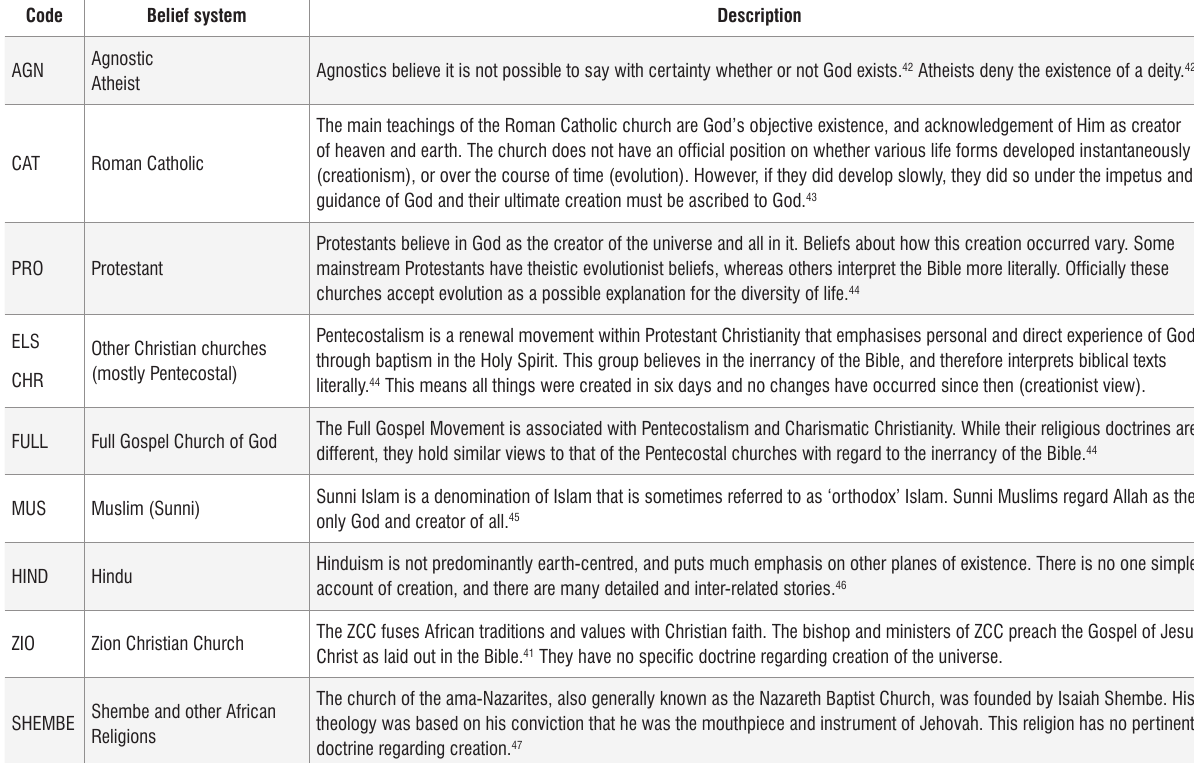
An adaptation of Scott’s creation–evolution continuum Flat Earth YOUNG EARTH Geocentrism Young Earth Creationism